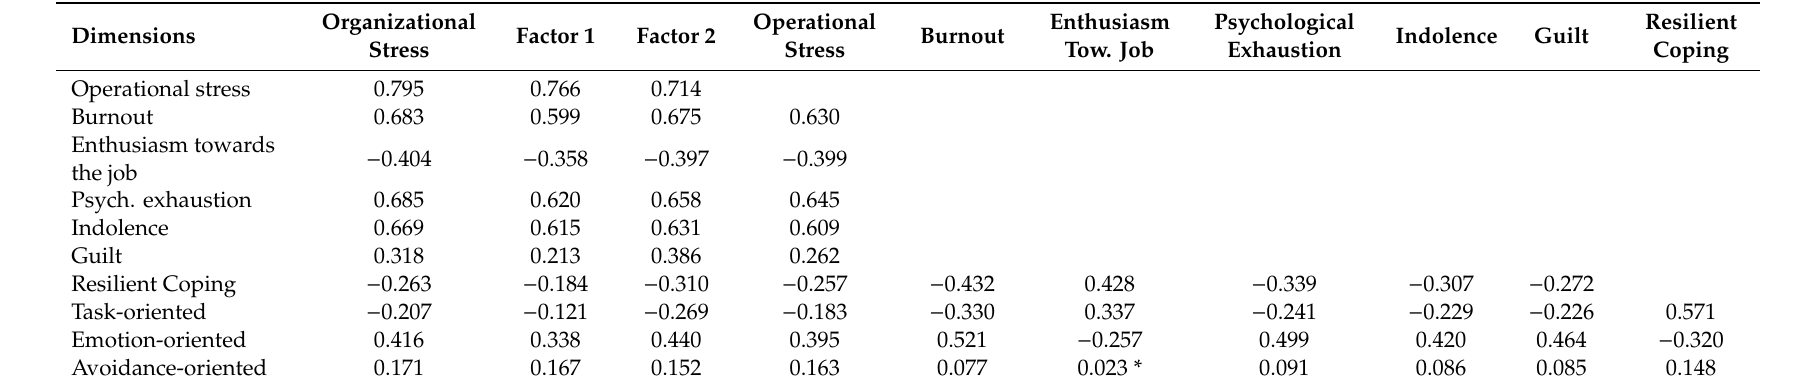
Table 5. Pearson correlations between Organizational police stress, Operational police stress, Burnout and Coping ( n = 1131).